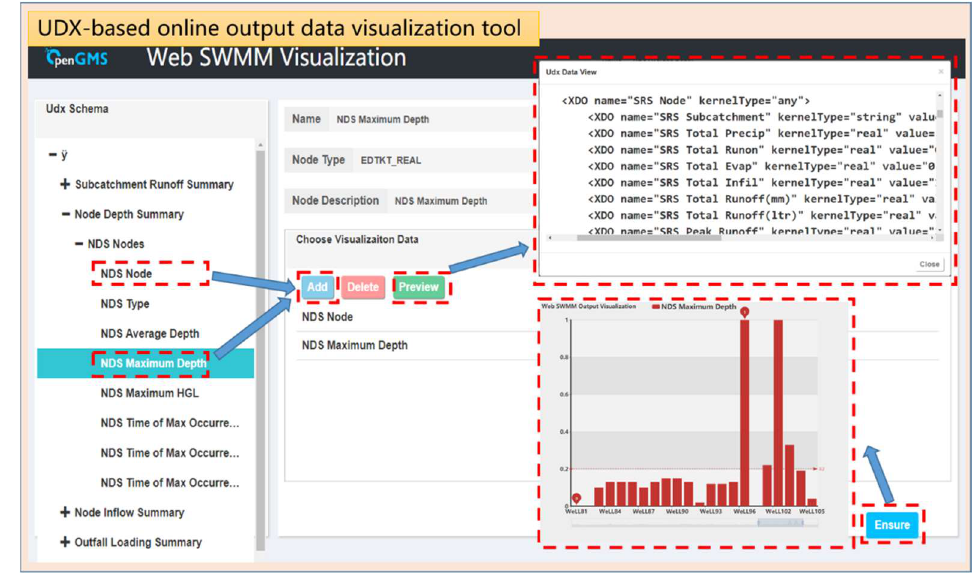
Figure 15. Output data visualization tool.